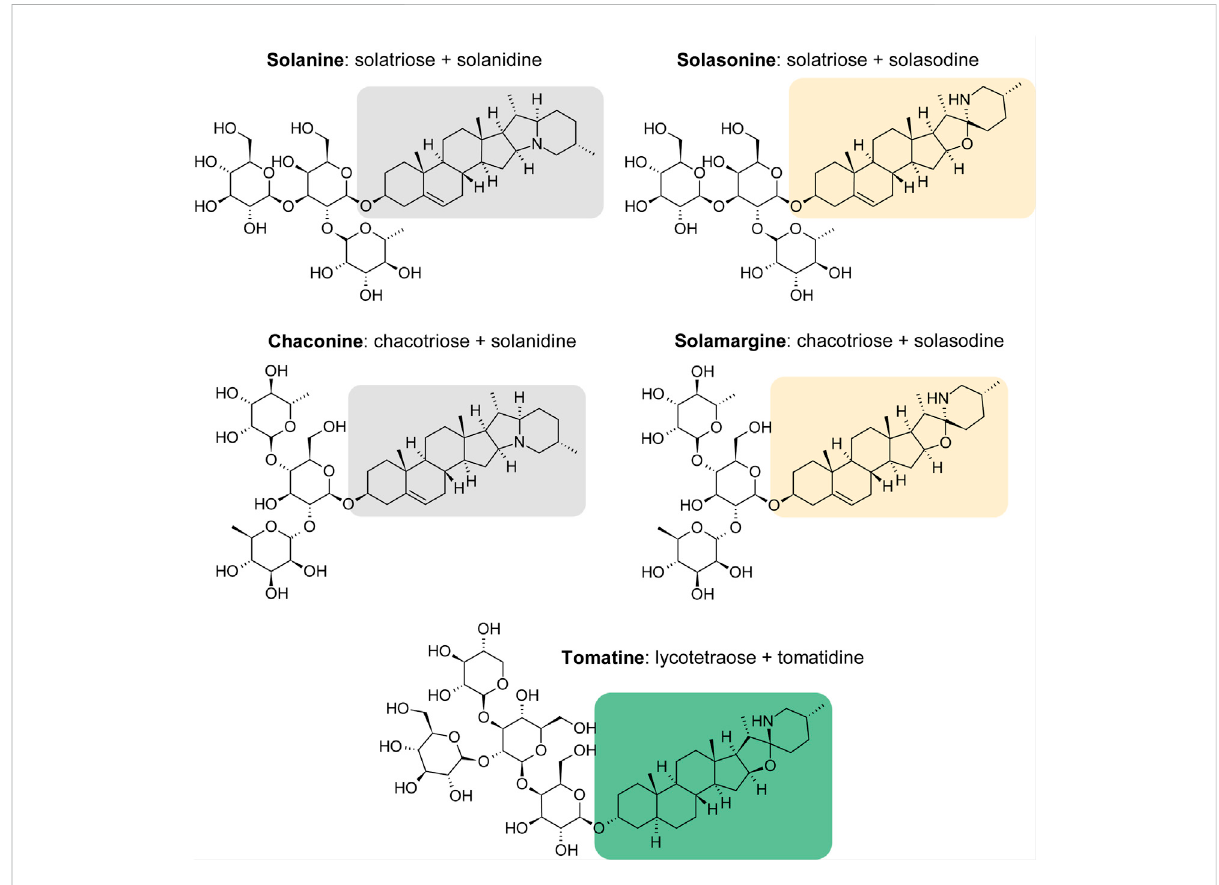
FIGURE 1 Structures of Solanaceae